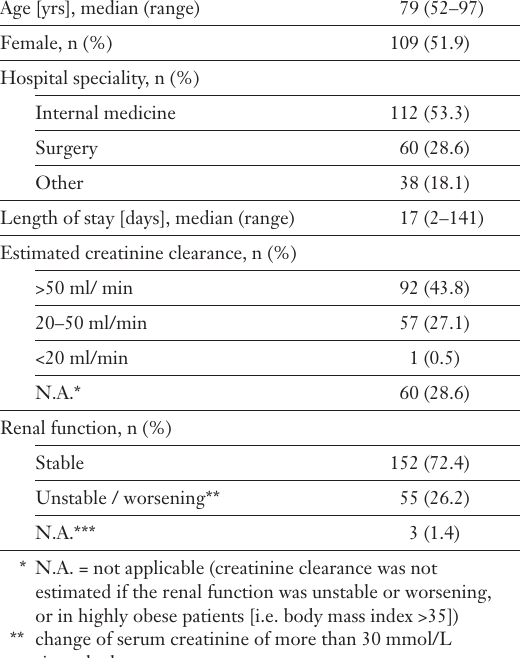
Table 1 Characteristics of 210 inpatients for whom digoxin levels were